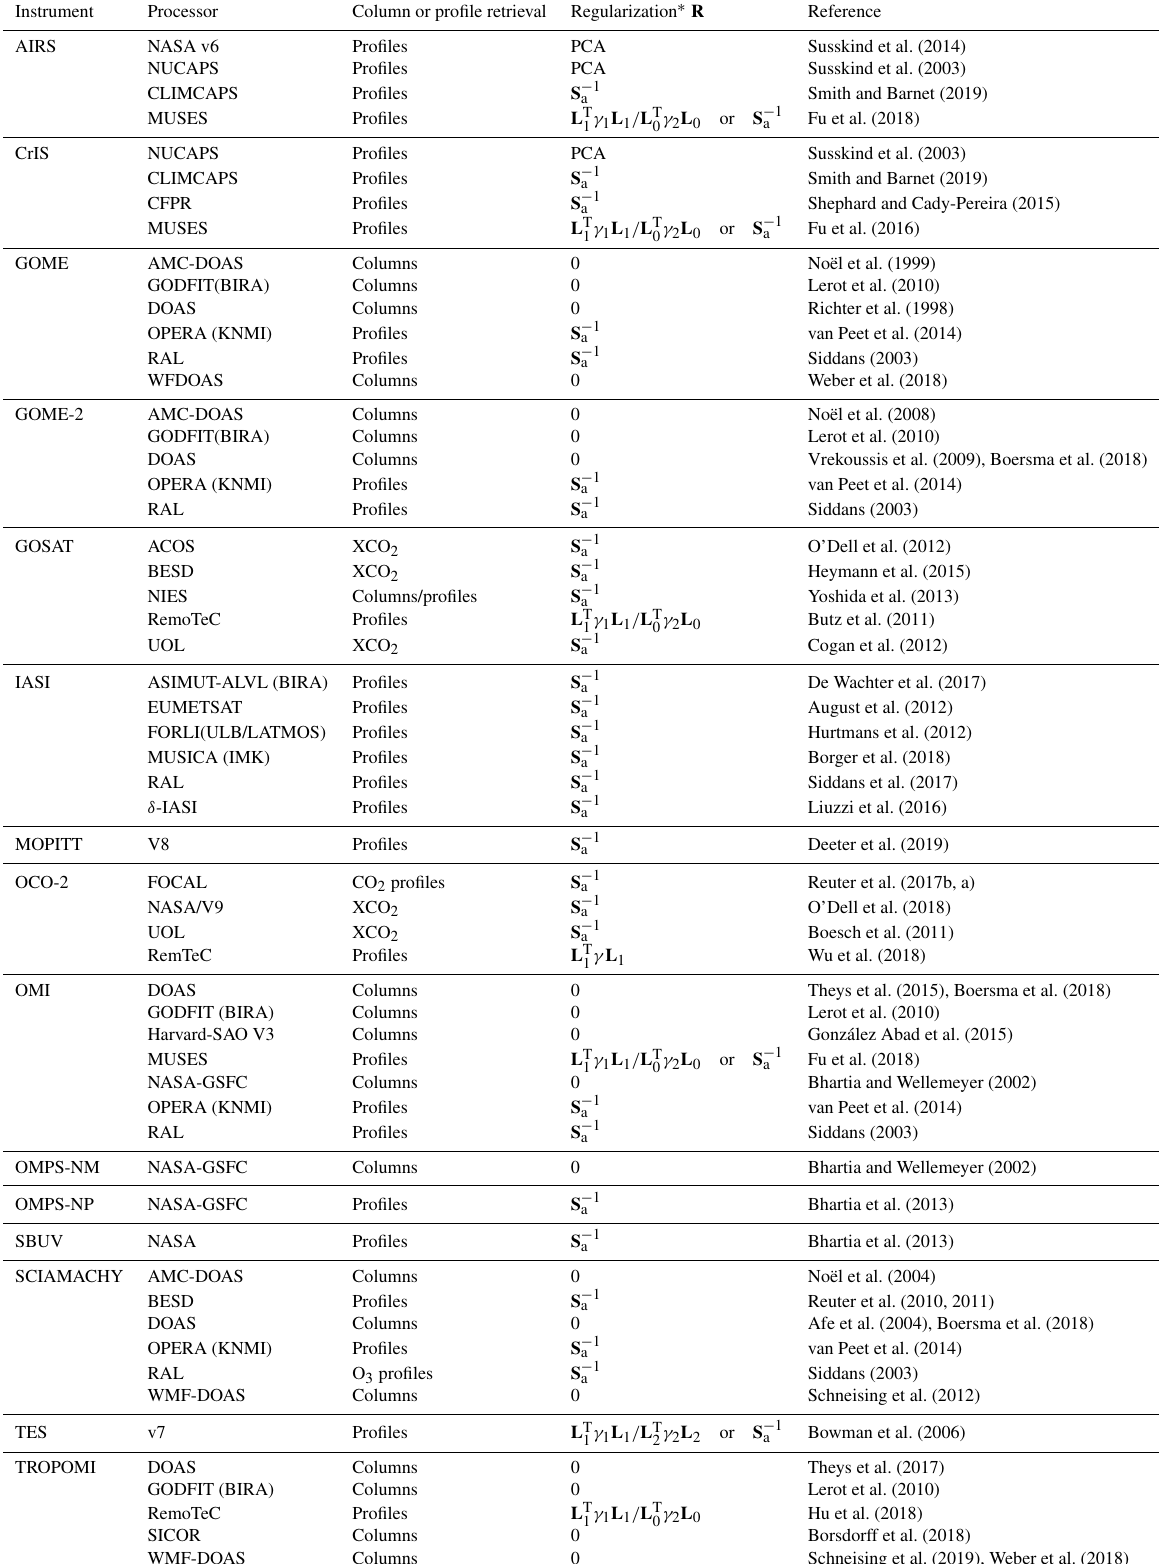
Table 2. Satellite data processors: nadir sounders.